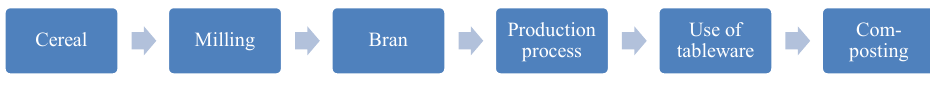
Fig. 1. Lifecycle of compostable tableware